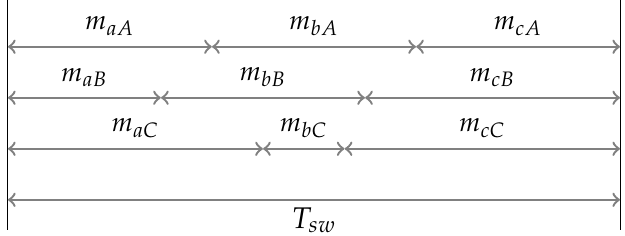
Figure 5. Single-side switching pattern for the duty-cycle modulation.